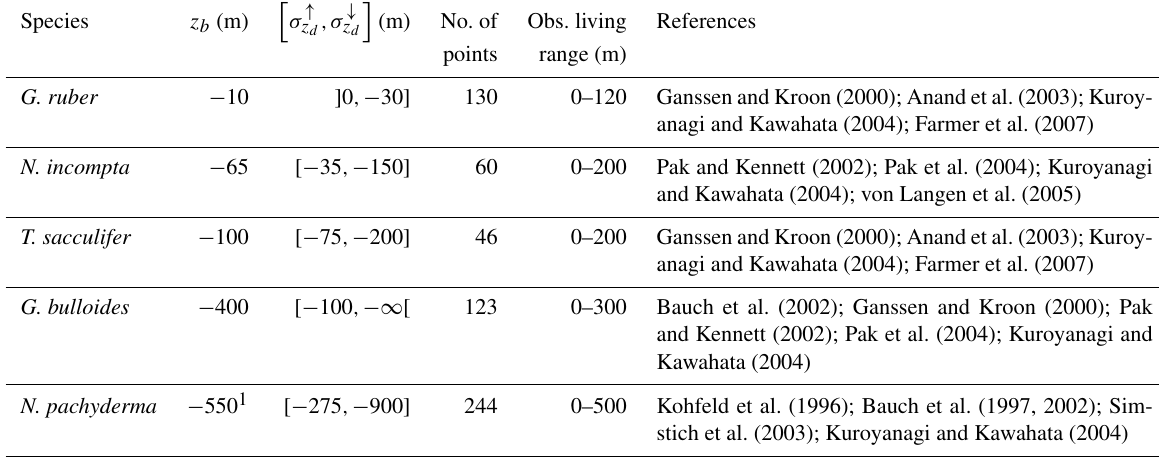
Table 1. Maximum depth per species as computed from the optimization procedure. z b is the depth yielding the smallest difference to the MARGO Late Holocene data (Waelbroeck et al., 2005). We computed a confidence interval ± 0 . 1permil in the mean error. The ∞ sign indicates that no value of z b within the range [0 , − 1500] yields the desired ± 0 . 1 permil change.